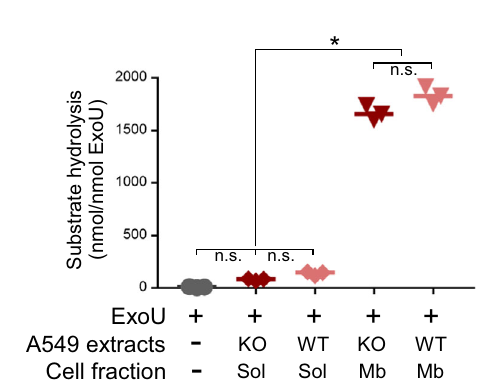
Fig. 6 ExoU phospholipase activity is independent of DNAJC5. Phospholipase activity of puri fi ed ExoU (65 pmols) was measured in the presence of soluble (Sol) or membrane (Mb) fractions from uninfected DNAJC5 − / − (KO) or DNAJC5 − / − ::DNAJC5 (WT) cells. Experiments were performed in triplicates and incubated for 24 h. Data are expressed in nmoles of substrate hydrolyzed per nmoles of ExoU ( n = 3; bar: median). Statistical differences were established by two-sided ANOVA ( p < 0.0001), followed by Tukey ’ s test (* p < 0.0001, n.s., non-signi fi cant). Source data are provided as a Source Data fi le. (REV.20170404). The library was ampli fi ed in Lucigen Endura electrocompetent cells (#60242) to reach at least 200x colonies per guide-RNA and the library plasmid pool was puri fi ed using NucleoBond Xtra-Midi EF Kit (Macherey-Nagel, #740420.50). Then, lentiviruses were produced by transfection of HEK293T cells with the library plasmid pool. In brief, X-tremeGENE 9 DNA Transfection reagent (Roche, #06365787001) was diluted in Opti-MEM serum-free media. Following 5min of incubation at room temperature, an appropriate mixture of plasmids was added in a 3:1 ratio of Transfection Reagent: DNA complex. This mixture of plasmids was composed of the library plasmid pool and the lentiviral packaging and envelope plasmids (psPAX2 and pMD2.G) at a 1:1:1 molar ratio 70 – 80% con fl uence HEK293T cells in a drop-wise manner and cells were incubated for 24 h. Following this incubation time, media were replaced by fresh DMEM, containing 6% of bovine serum albumin (BSA). The next day, the lentiviruses- containing media were harvested, centrifuged to pellet any packaging cells, and supernatants were stored at − 80°C. The lentiviral concentration was established by serial dilutions on A549 cells, as described below, treated or not treated with 2 µg mL − 1 puromycin. The virus volume that gave 30% survival with puromycin selection vs without puromycin was chosen for library construction, in order to limit the number of lentiviruses per cell.